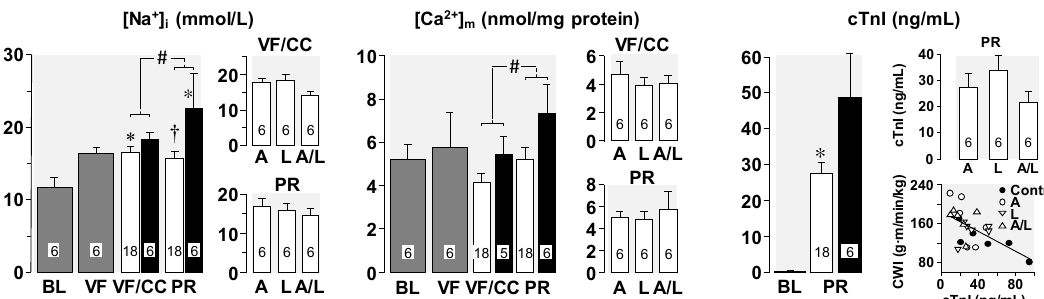
Figure 8. Left ventricular intracellular Na + ([Na + ] i ), mitochondrial Ca 2 + ([Ca 2 + ] m ), and cTnI ( C ) at baseline (BL), at 15 min of untreated VF, at 15 min of VF with chest compression during the last 5 min (VF / CC), and at 60 min post-resuscitation (PR). Black bars denote control rats and white bars denote rats treated with Na + -limiting interventions. Also shown are the e ff ects of individual Na + -limiting interventions. A, AVE4454B and lidocaine vehicle; L, lidocaine and AVE4454B vehicle; and A / L, AVE4454 and lidocaine. Mean ± SEM. ∗ p < 0.05 vs. BL by Kruskal-Wallis one-way ANOVA on ranks using Dunn’s Method for multiple comparisons; † p < 0.05 vs. control by Student’s t-test in PR groups; # two-way ANOVA using time factor (VF / CC vs . PR) and treatment factor (control vs. Na + -limiting interventions) was significant for treatment factor ( p = 0.013) for [Na + ] i and for both, time factor ( p = 0.045) and treatment factor ( p = 0.021) for ([Ca 2 + ] m . Also shown is an attenuation of post-resuscitation cTnI increased with the Na + -limiting interventions ( ∗ p < 0.05 vs. control by Student’s t-test) and an inverse relationship between cardiac work index (CWI) and cTnI levels ( r = 0.58, n = 24, p < 0.01) (adapted with permission from Wang et al. [19]). Please confirm if it is necessary to explain # in the